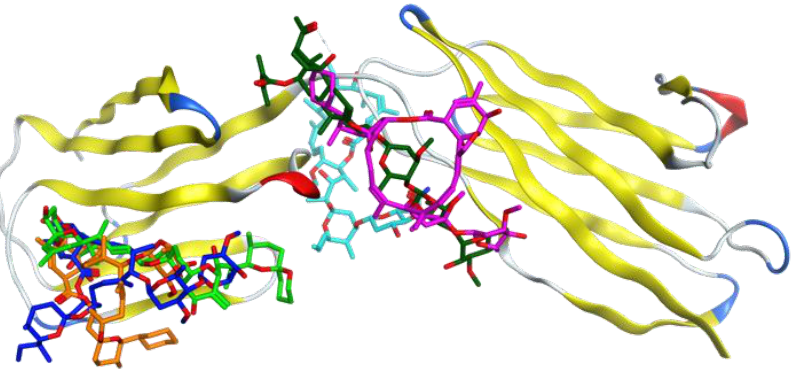
Figure 3. Binding poses of okadaic acid (green), doramectin (purple), selamectin (orange), P-57AS3